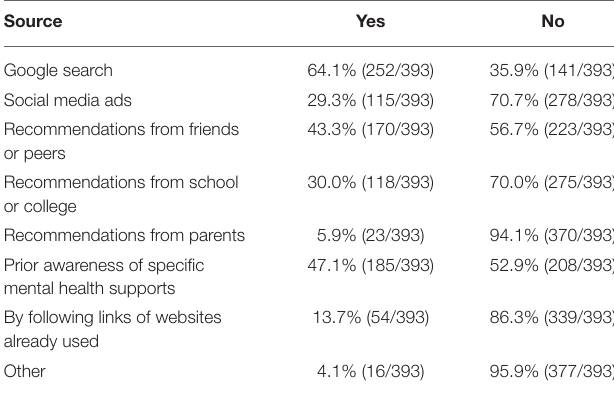
TABLE 6 | Locating mental health resources